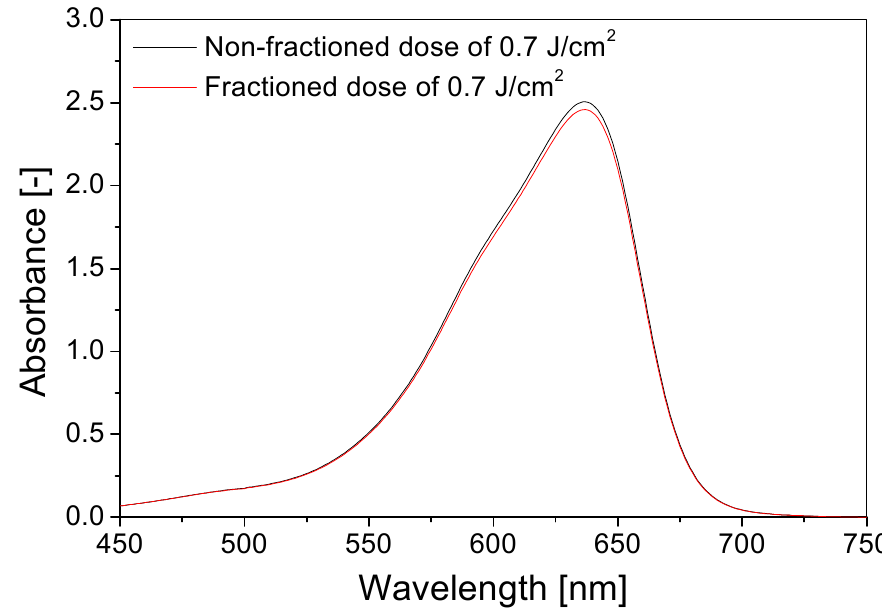
Figure 5. A comparison of TBO–Pluronic F–127 gels (60 µ M TBO, 5% H 2 O 2 , 25% Pluronic F–127) irradiated with fractioned and non-fractioned doses equal to 0.7 J/cm 2 of UVB radiation. Table 3. Basic parameters of TBO ‒ Pluronic F ‒ 127 dosimeter (60 μ M TBO, 5% H 2 O 2 , 25% Pluronic F–127) irradiated with UVA, UVB and UVC radiation, derived from the dose–responses (Figure 4). The linear equation is for the linear (for samples irradiated with UVA, UVB, UVC) and dynamic (for samples irradiated with UVC) dose range, whereas the polynomial equation is for the dynamic dose range of samples irradiated with UVA and UVB.